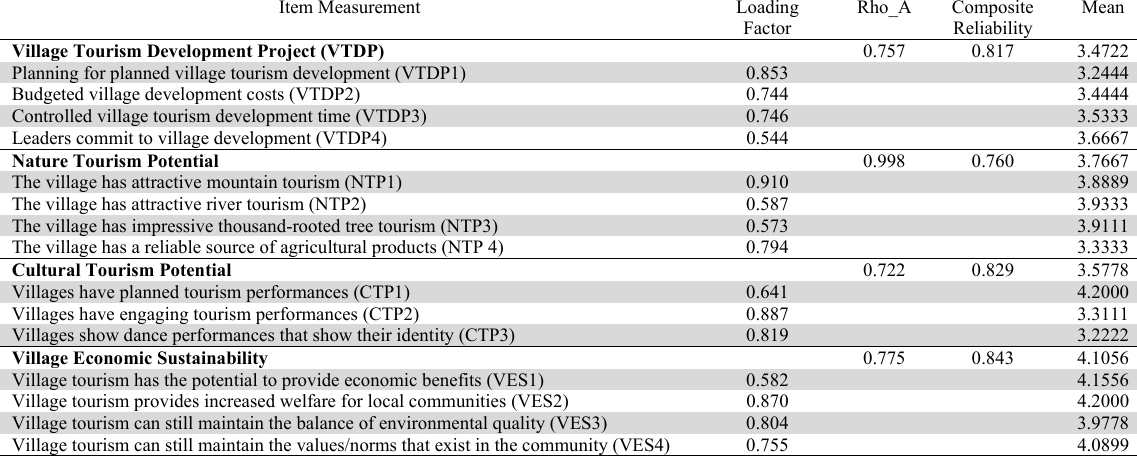
The goodness of fit Item Measurements